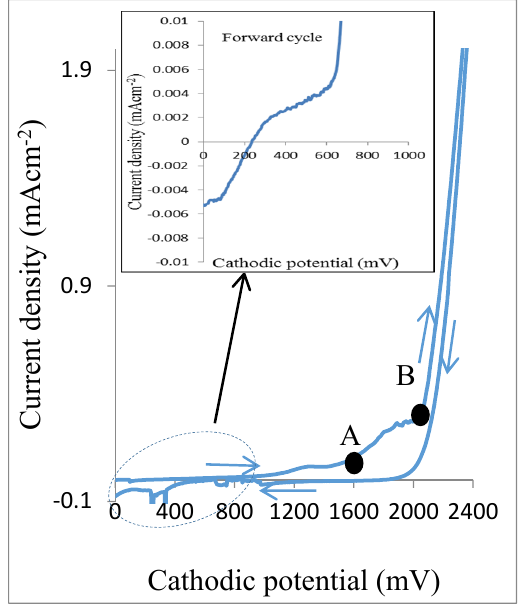
Figure 1. Two-electrode cyclic voltammogram of CdTe deposition aqueous electrolyte containing 1.0 M CdSO 4 , 1 mM TeO 2 , 1 mM CdCl 2 and 1 mM CdF 2